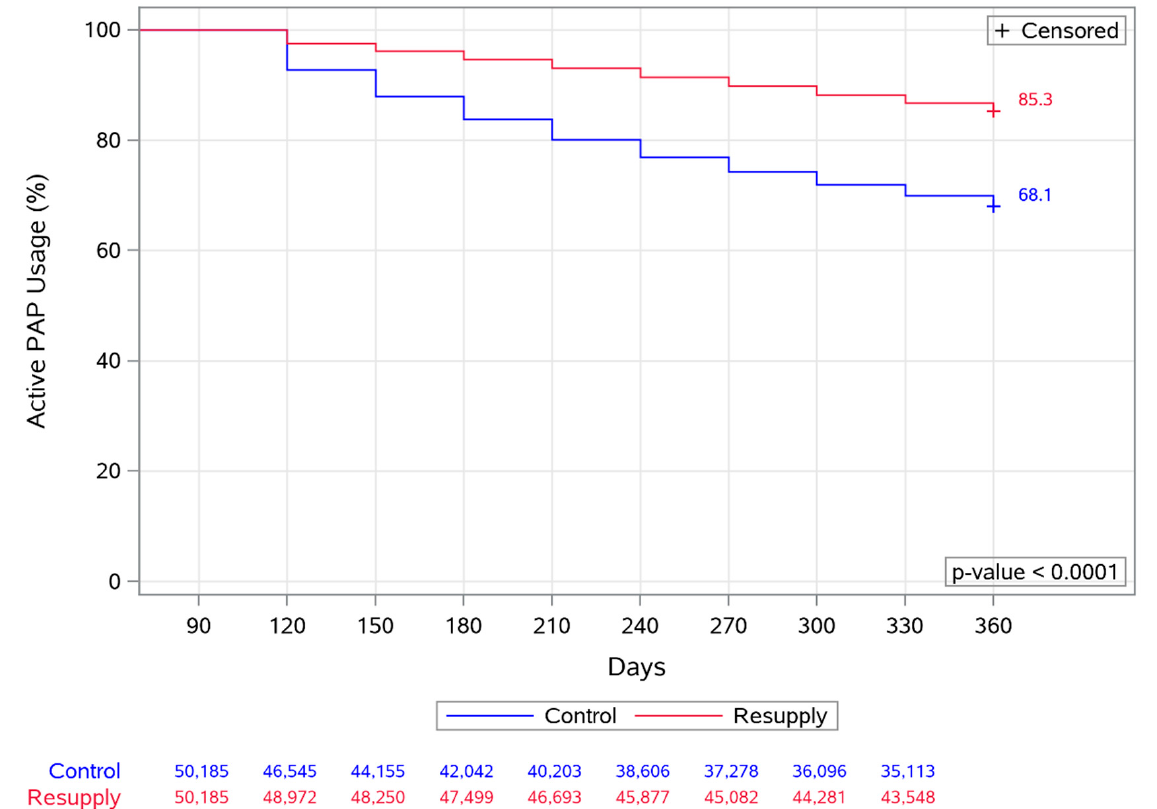
Figure 2. Overall probability of continuing with the positive airway pressure (PAP) therapy (“survival” of therapy) from days 91–360 in the control and resupply groups (primary analysis population). +Censored, patients whose therapy continued after 360 days were censored at the 360 day time